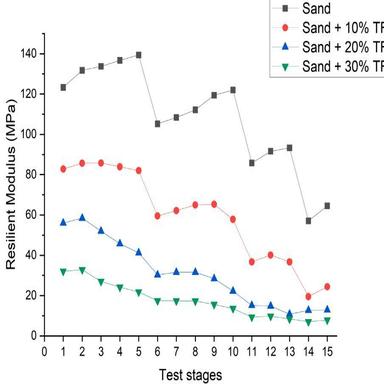
Variation in resilient modulus (MR) with test sequences.